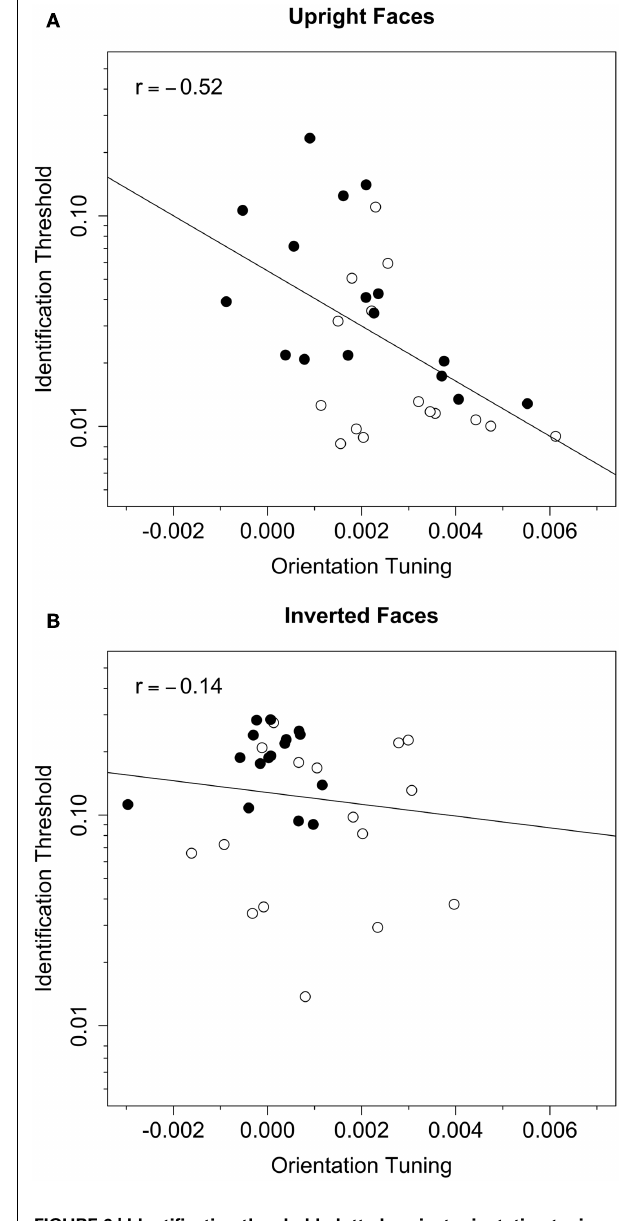
Table 2 |ANOVA tables for linear models predicting identification